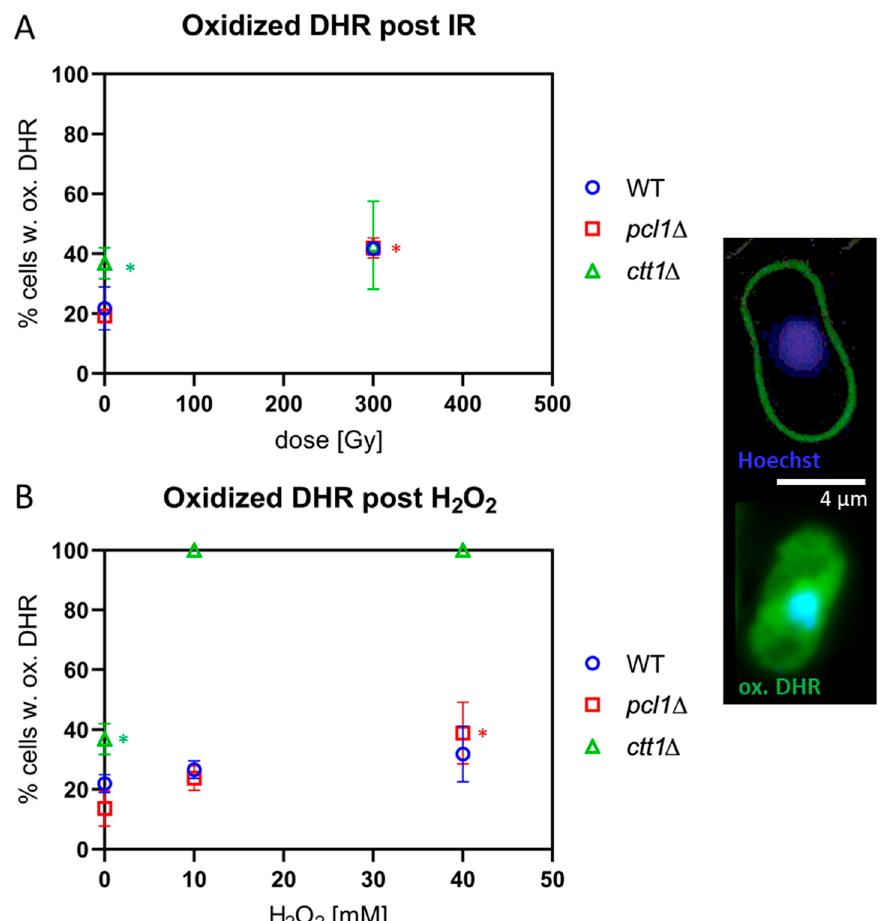
Figure 4. ROS formation as revealed by Dihydrorhodamine (DHR) staining. Images displayed to the right show a negative (upper cell) and a cell positive for oxidized DHR (ox.DHR; green) are. Bar = 4 µm. ( A ) Meiocytes exposed to 300 Gy of IR displayed similar average levels of ROS as indicated by ox.DHR in wild-type (WT), pcl1 ∆ , and ctt1 ∆ strains. Among the non-exposed cells ctt1 ∆ meiocytes displayed the highest fraction of ox.DHR-positive cells, a significant difference (* p = 0.001). IR induced an increase of the percentage of ox.DHR-positive cells that is significant at 300 Gy for pcl1 ∆ and WT cells (* p < 0.05), while it is not significant for ctt1 ∆ meiocytes, because of the variable staining results with this mutant. ( B ) Exposure of meiocytes to H 2 O 2 induced an increase in the average percentage of ox.DHR-positive meiocytes in WT and pcl1 ∆ relative to their control, which was significant for pcl1 ∆ at 40 mM ( p = 0.0034). H 2 O 2 treatment killed all ctt1 ∆ meiocytes that all were positive for ox.DHR. Data points represent the average of 3 independent experiments ± SD.